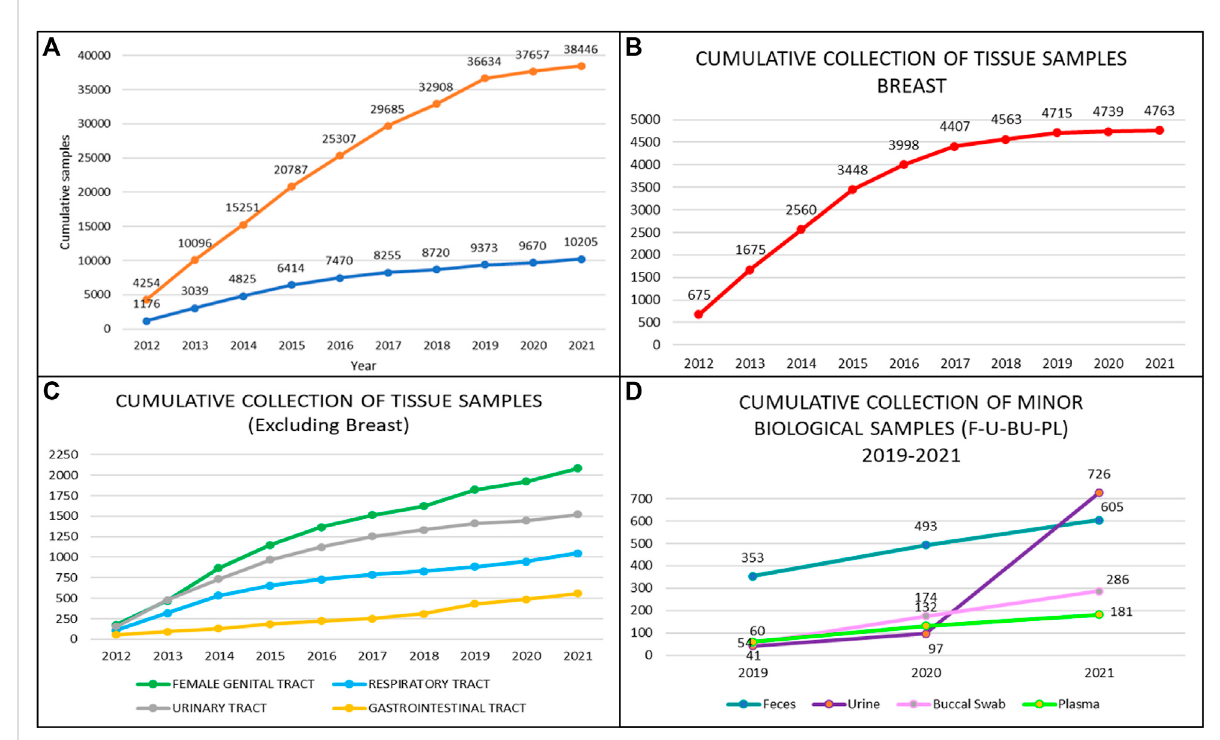
FIGURE 3 Types and number of samples collected by the biobank of the European Institute of Oncology by year. (A) Cumulative collection of tissue and blood/serumsamples; (B) Cumulativecollectionofbreasttissuesamples; (C) Cumulativecollectionoftumorsamplesfromtheovary,prostate,lung, and colon; (D) Cumulative collection of non-tissue samples, i.e. feces, saliva/swab, plasma, and